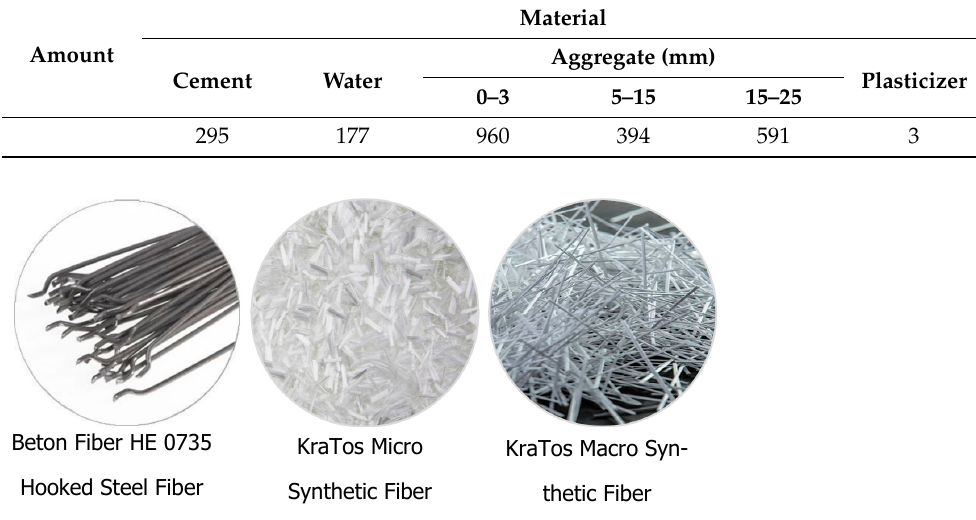
Table 2. Mix design of conventional concrete (kg/m 3 ).